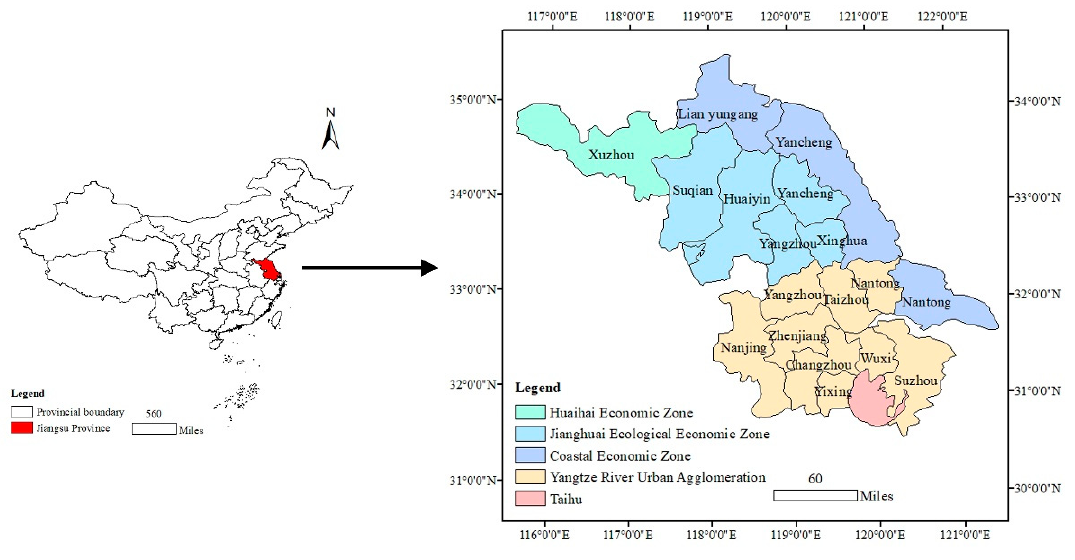
Figure 1. Location of the study area.